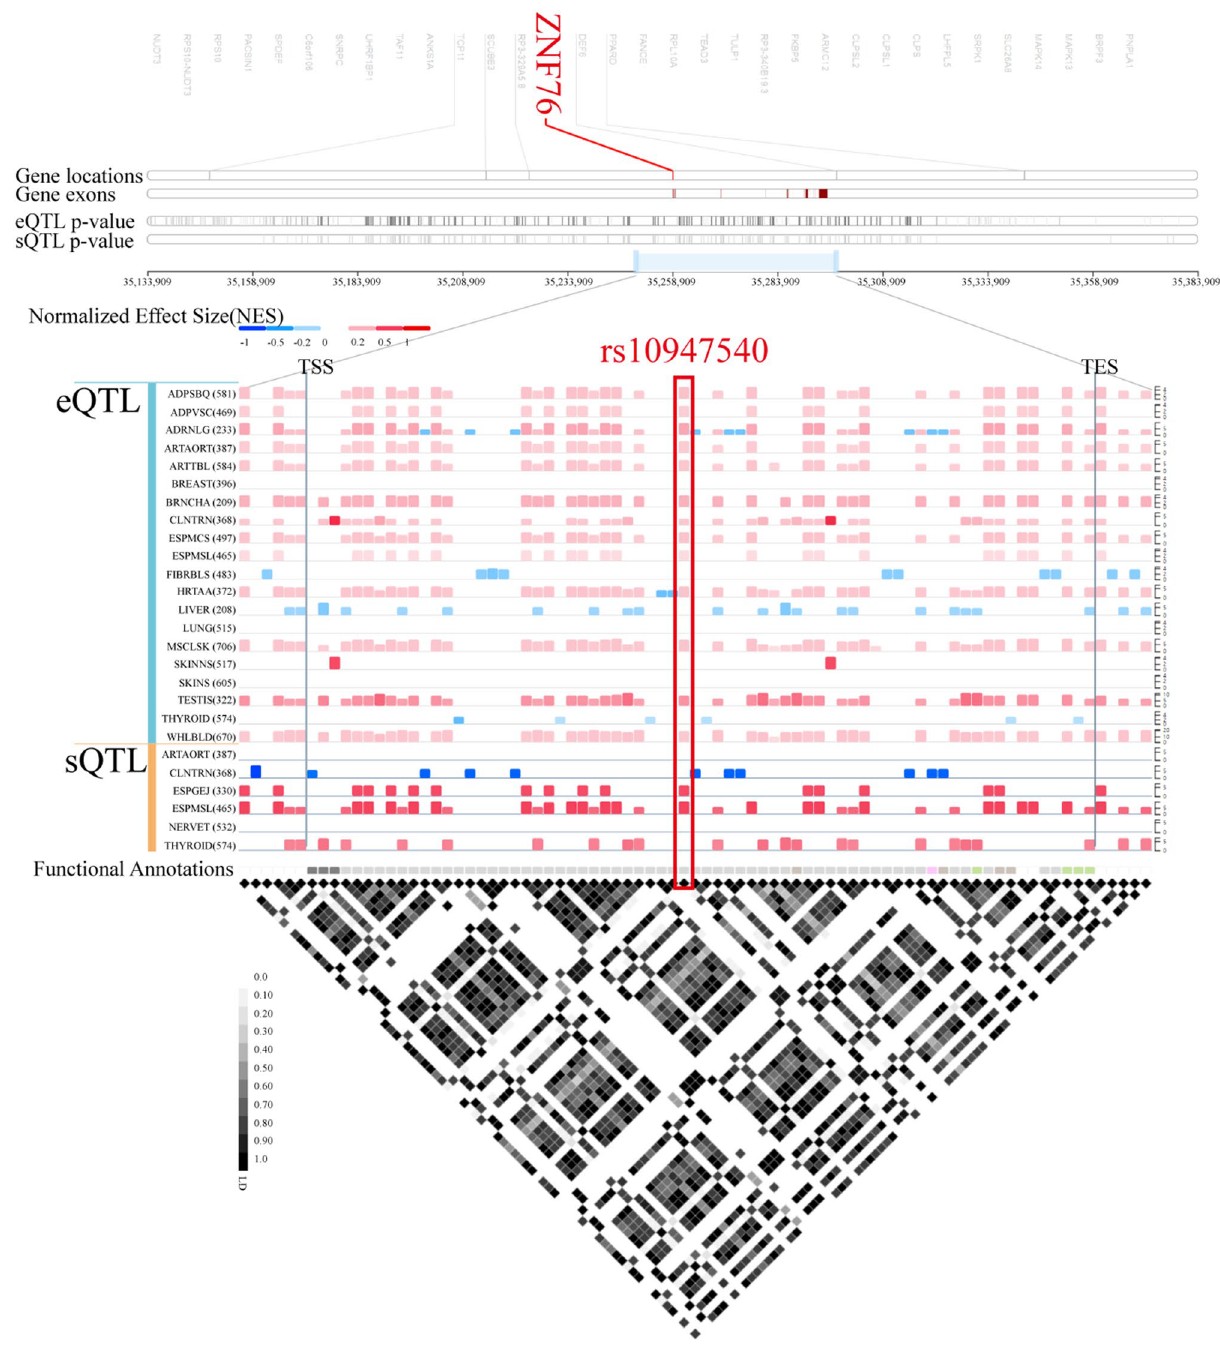
Figure 2. ZNF76 rs10947540 is an QTL locus. The quantitative trait locus in ZNF76 were generated by GTEx Locus Browser. ZNF76 rs10947540 was had eQTL and sQTL effects in multiple